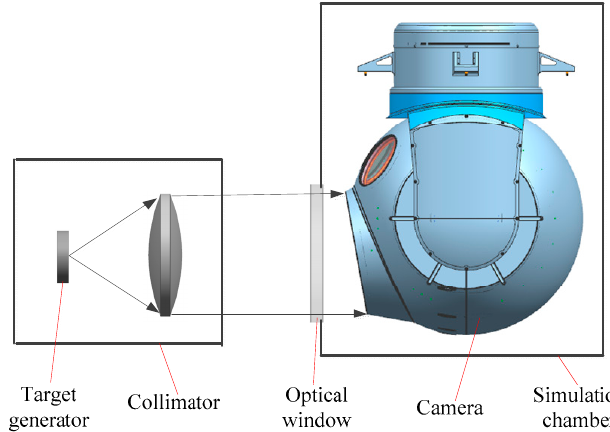
Figure 1. Original thermal control design of the optoelectronic sensor.